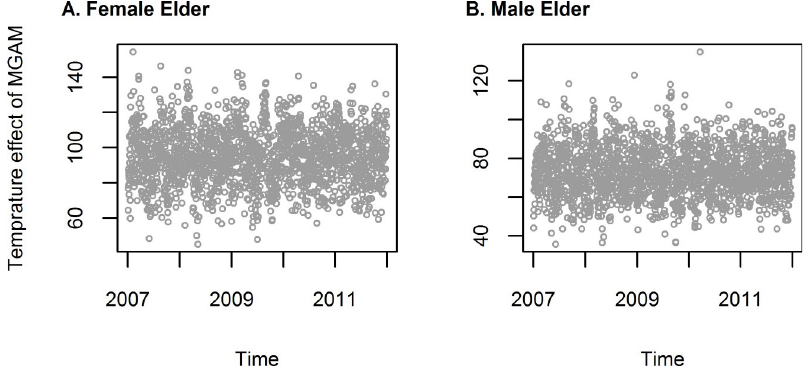
Fig 5. No seasonal pattern temperature after arbitrary set of degree of freedom of natural spline at 4 per year (df t = 20).